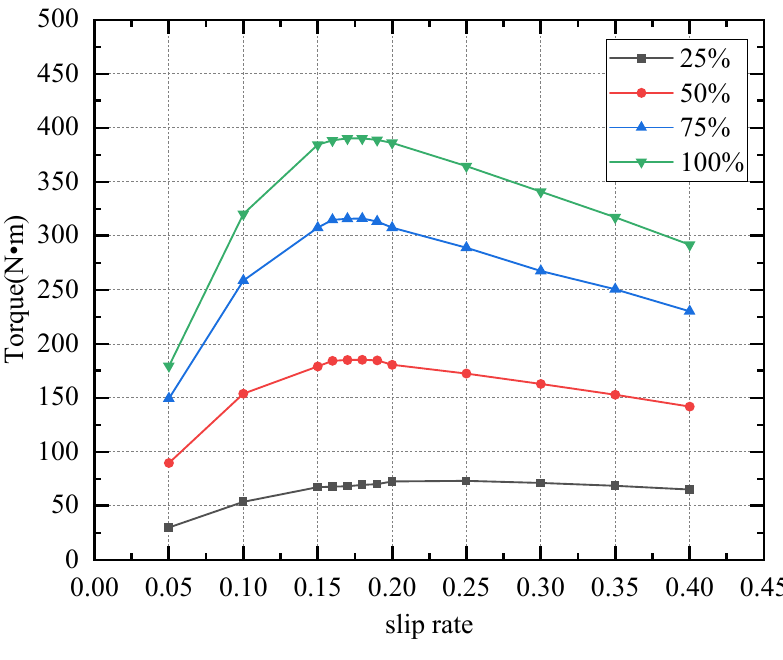
Figure 13. Average output torque at different effective coupling ratio.